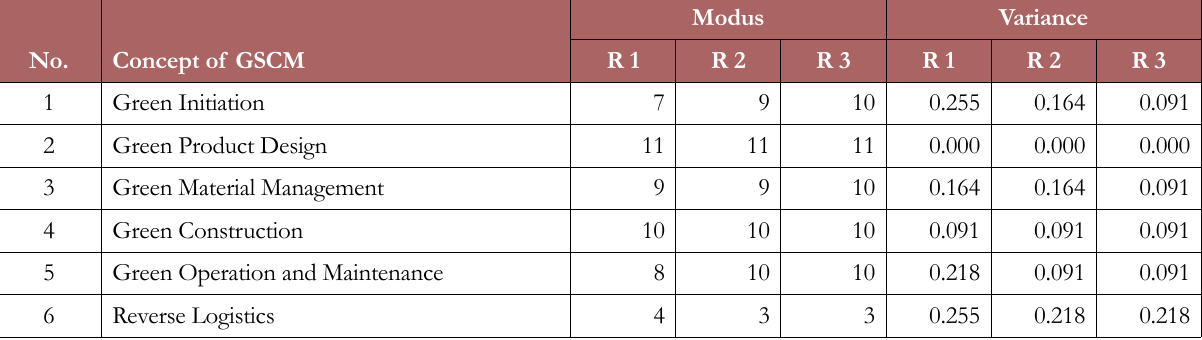
Table 5. Delphi Results for GSCM Concepts in the Construction